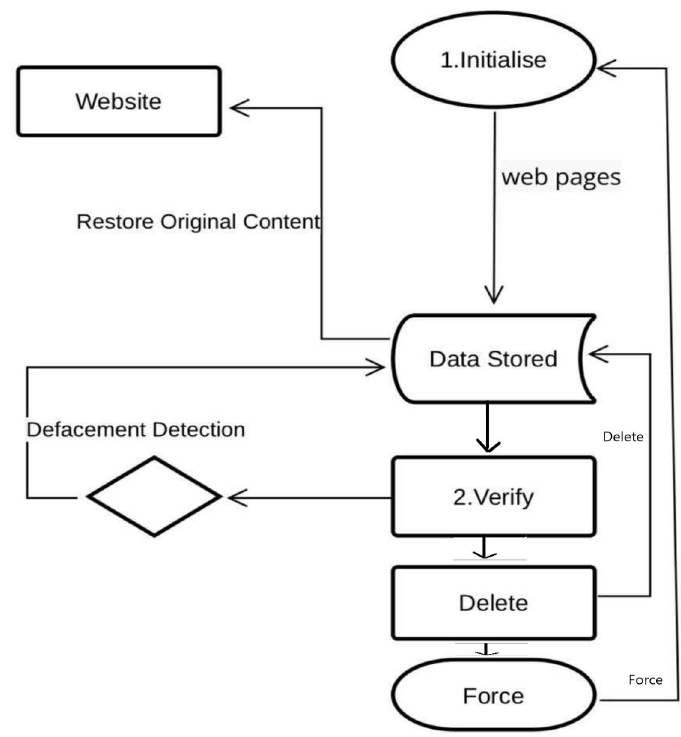
Figure 10. WDIMT tool